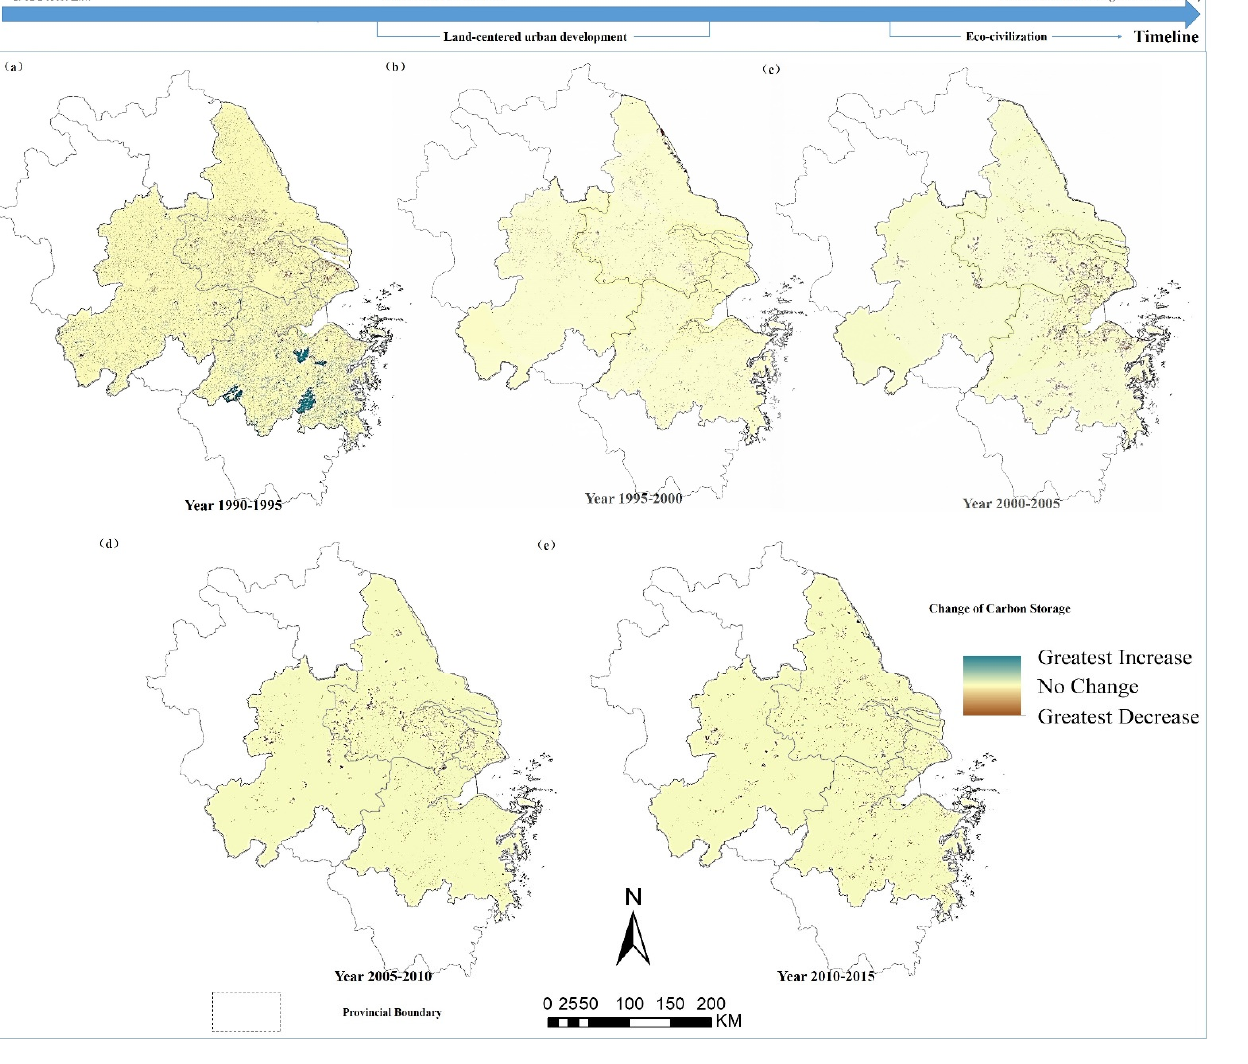
Figure 4. Spatiotemporal change of carbon storage (carbon sequestration) and progress in land use policy in Yangtze River Delta Region (1990–2015). ( a ) Spatiotemporal change of carbon storage in 1990–1995; ( b ) Spatiotemporal change of carbon storage in 1995–2000; ( c ) Spatiotemporal change of carbon storage in 2000–2005; ( d ) Spatiotemporal change of carbon storage in 2005–2010; ( e ) Spatiotemporal change of carbon storage in 2010–2015. The timeline above illustrates the progress in land use policy in the Yangtze River Delta Region (1990–2015).